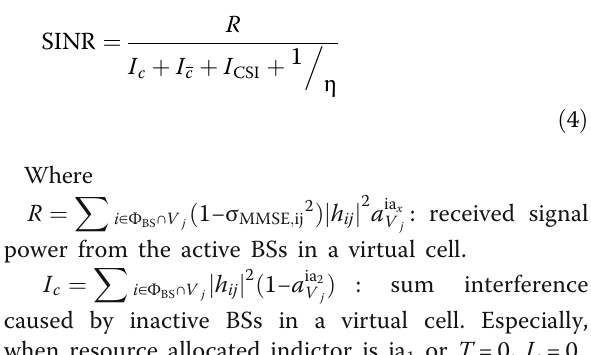
X h ij S j a ia x V j þ i ∈